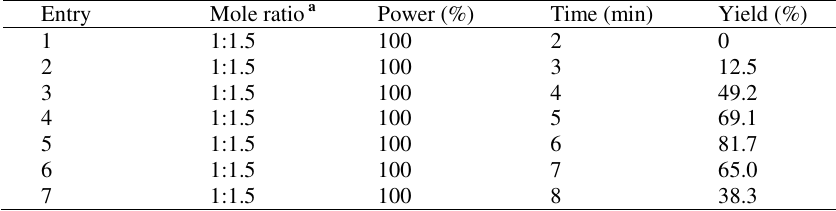
Table 3 Change the reaction time of the condensation